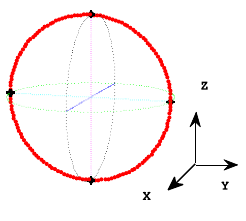
Figure 10. Phase portrait of system (1.3) at infinity.